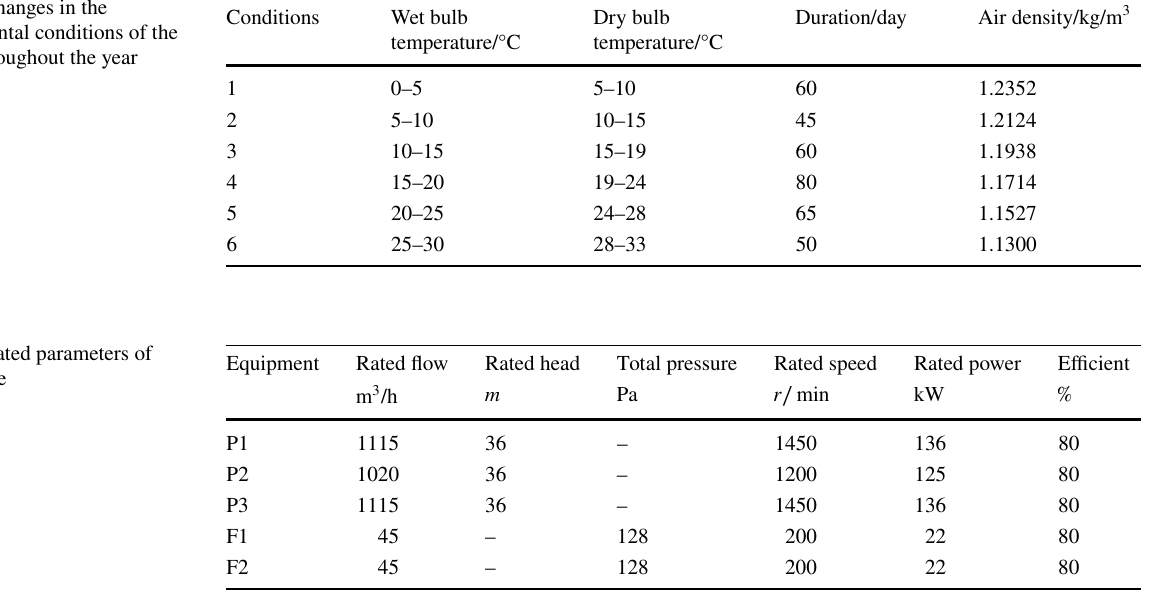
Table 3 Changes in the